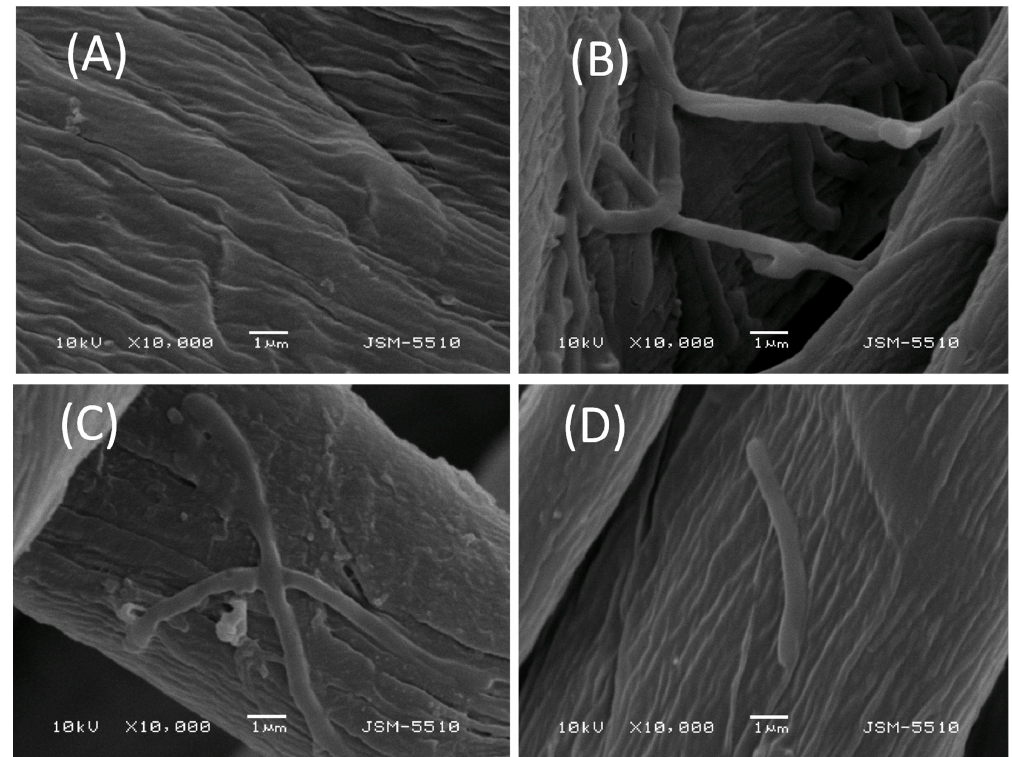
Figure 6. SEM micrographs of cotton fabric samples tested against B. cereus at a 10,000× magnification: ( A ) virgin cotton fabric; ( B ) biofilm on a virgin cotton fabric; ( C ) reduced biofilm formation on a S1-treated cotton fabric; ( D ) absence of biofilm on cotton fabric treated with [Cu 3 (S1)].